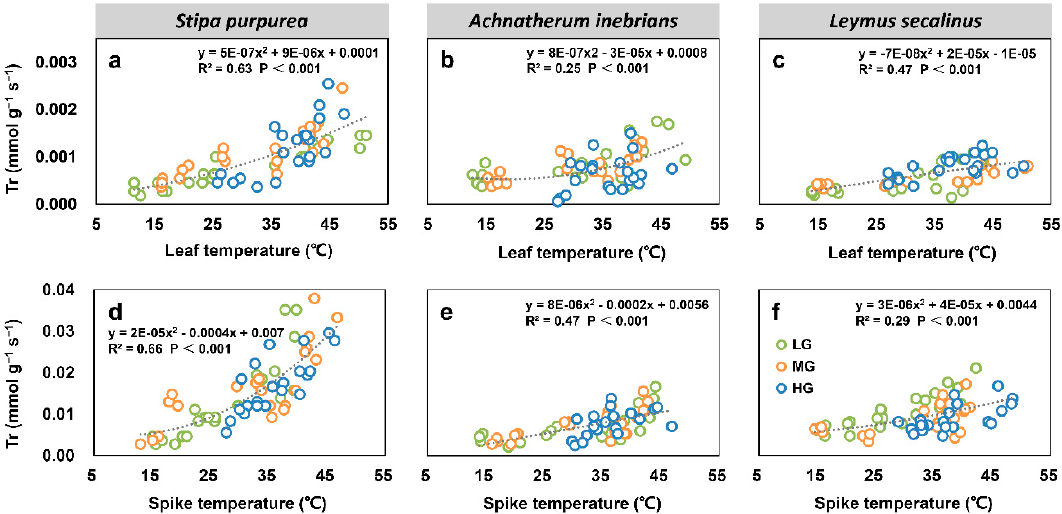
Figure 9. Correlations between leaf transpiration rate (Tr) and leaf temperature (T l ) (top), and between spike Tr and spike temperature (T s ) (bottom) of S. purpurea ( a , d ), A. inebrians ( b , e ) and L. secalinus ( c , f ) under grazing intensity (LG, light grazing; MG, medium grazing; HG, heavy grazing).